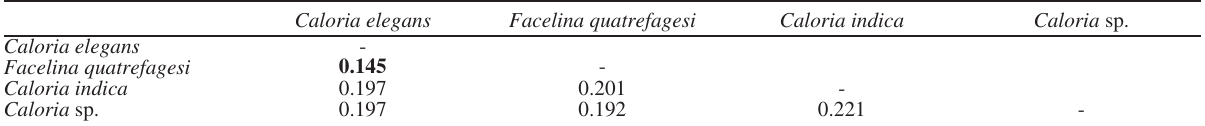
Fig. 5. – Phylogenetic relationships among facelinid species based on Bayesian analysis of the partitioned (H3, COI and 16S) combined dataset. Numbers at nodes are Bayesian posterior probability and ML bootstrap support, respectively. The histogram shows the distribution of the pairwise estimated genetic distances (K2p) in intraspecific (light grey, left) and interspecific (dark grey, right) comparisons. Table 2. – Mean distance between groups on the barcode marker COI (p-distance